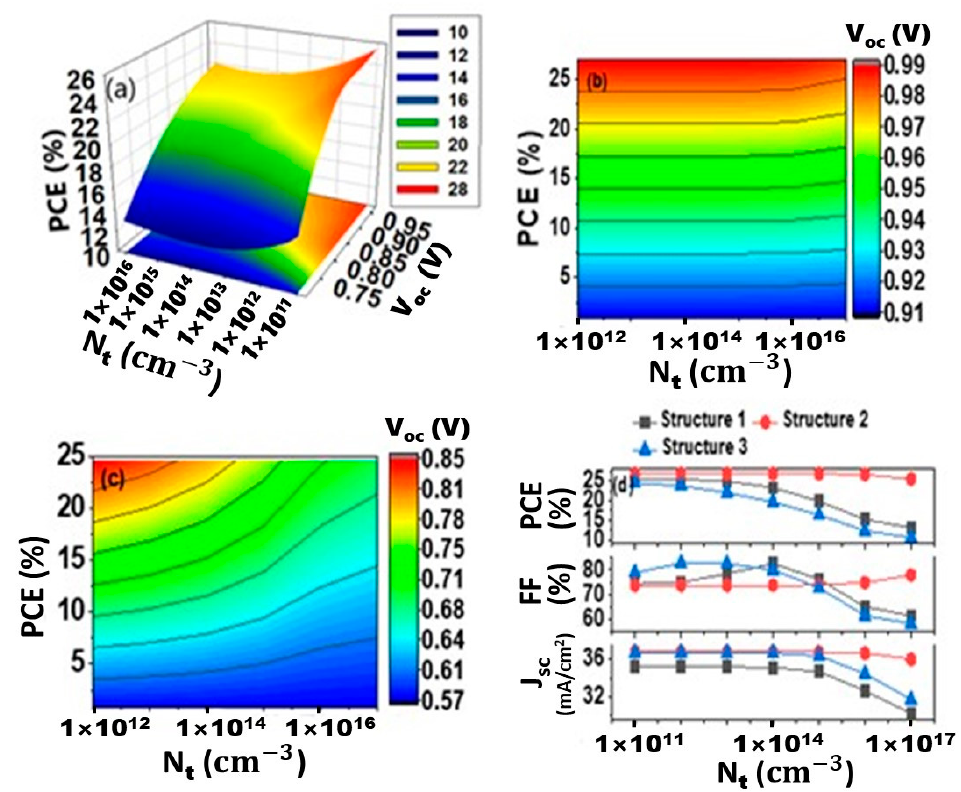
Figure 4. Effect of interfacial defect concentration (N t ) at ETL/Absorber layer; PCE and V oc vs. interfacial defect concentration for ( a ) Structure 1, ( b ) Structure 2 and ( c ) Structure 3, ( d ) J sc , FF and PCE vs. the interfacial defect concentration in IL1.